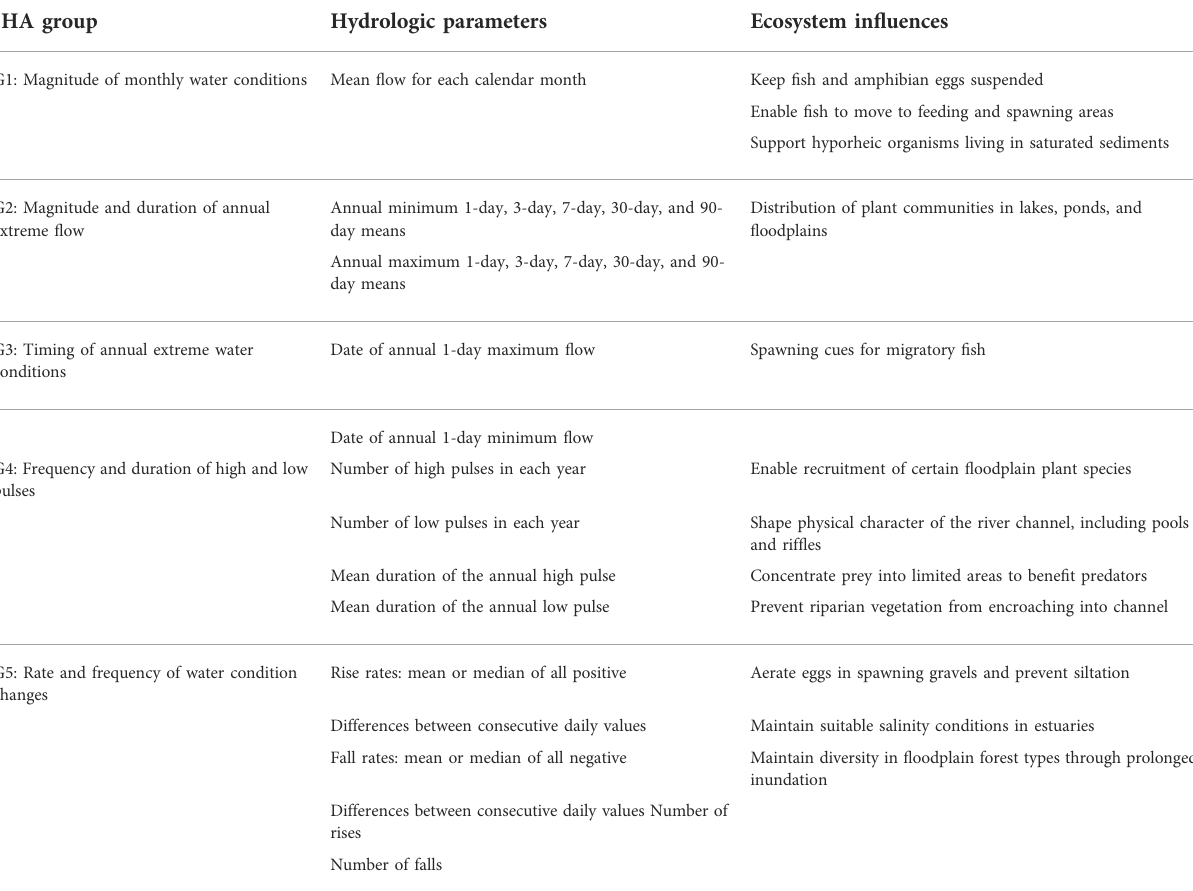
TABLE 1 IHA parameters and the impact on ecosystems (Richter and Thomas, 2007; Ge et al., 2018). IHA